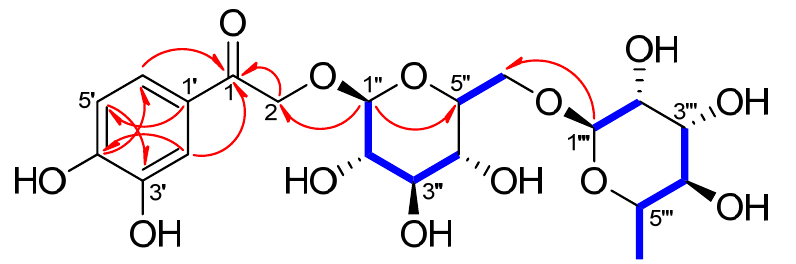
Figure 3. Key 1 H − 1 H COSY ( ▬ ) and HMBC ( ) correlations of compound 1 .